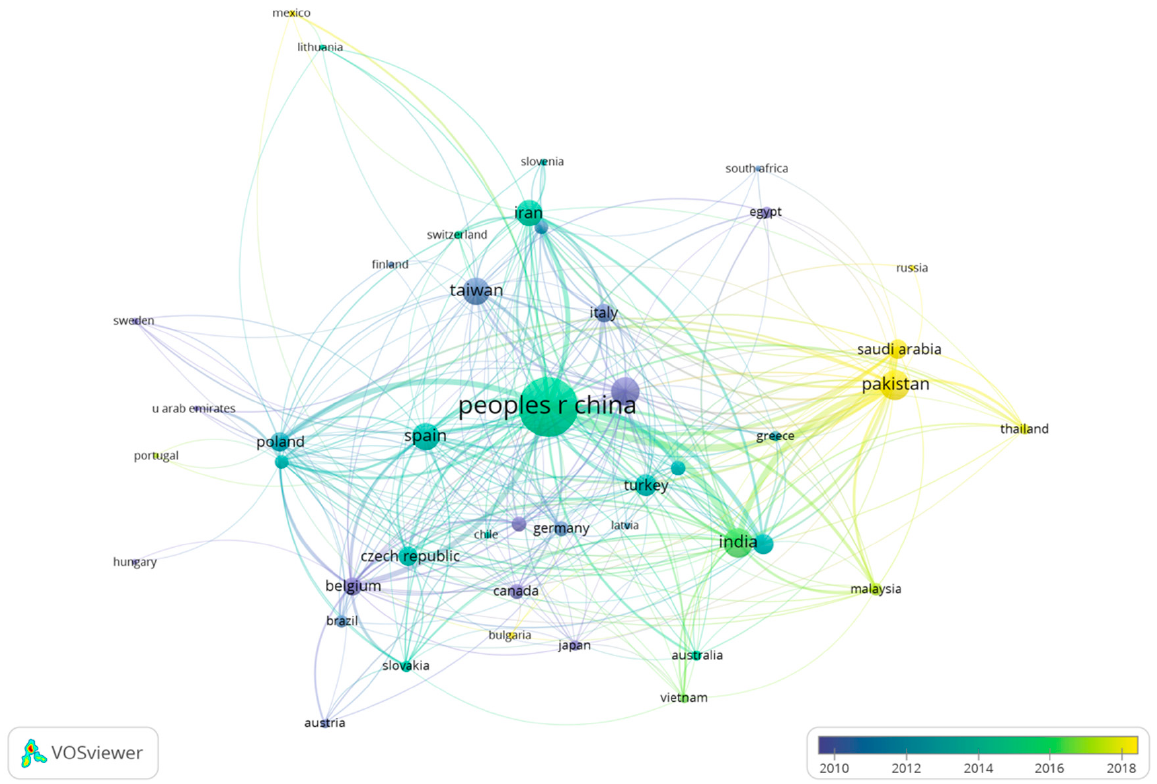
Figure 8. Bibliographic coupling for countries. Overlay visualization.